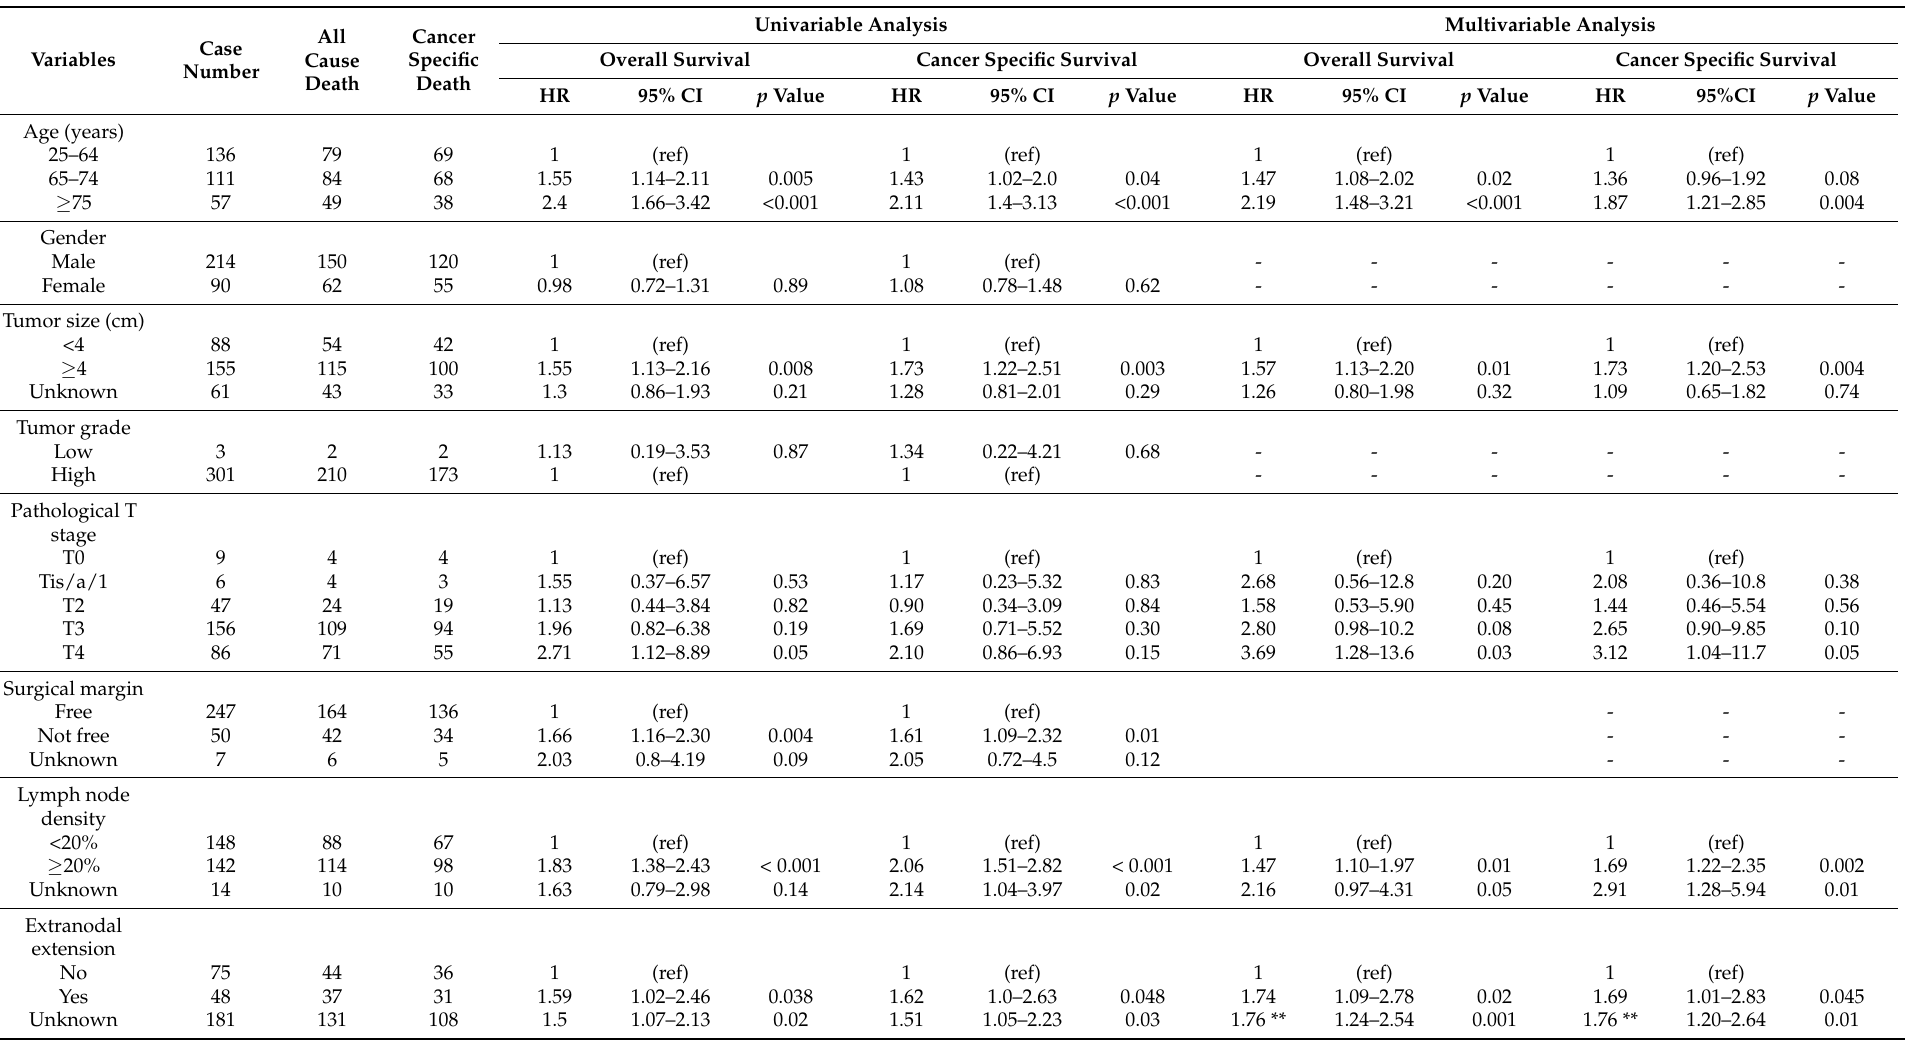
Table 2. The Cox proportional hazard models of overall and cancer-specific survival in bladder cancer patients with lymph node involvement who received radical cystectomy.